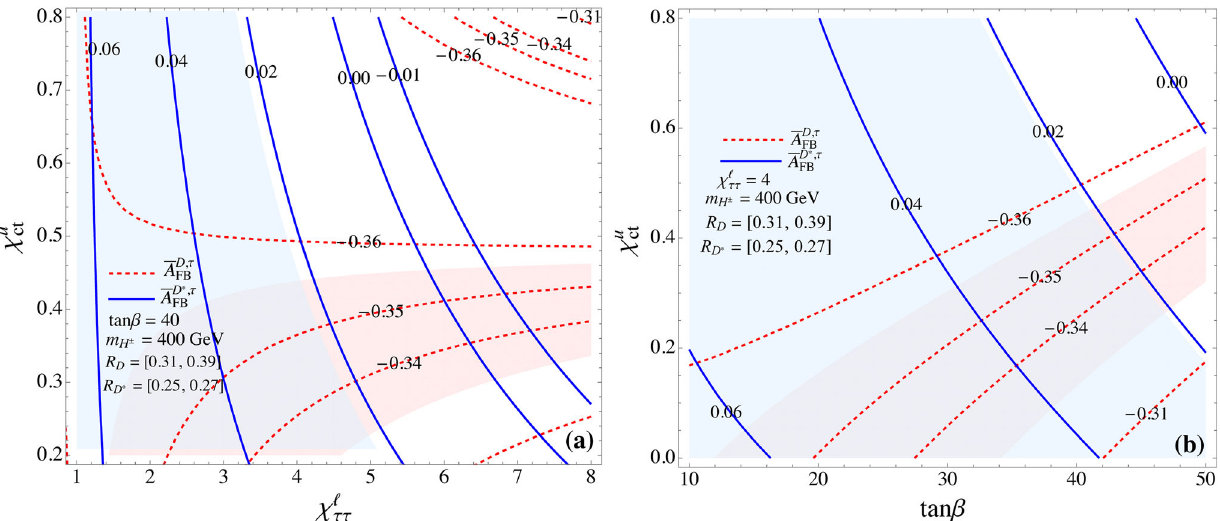
Fig. 4 The legend is the same as that in Fig. 3, but for FBA, defined in Eq.